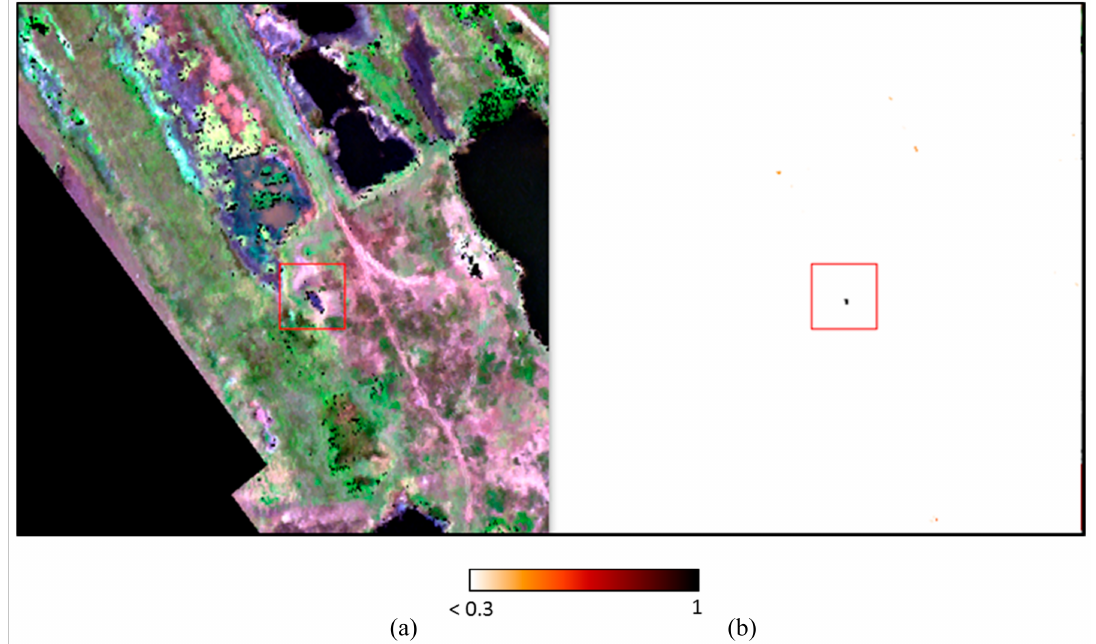
Figure 19. RGB HySpex image ( a ), Normalized Area1700 applied to the most anomalous 1/1000 pixels ( b